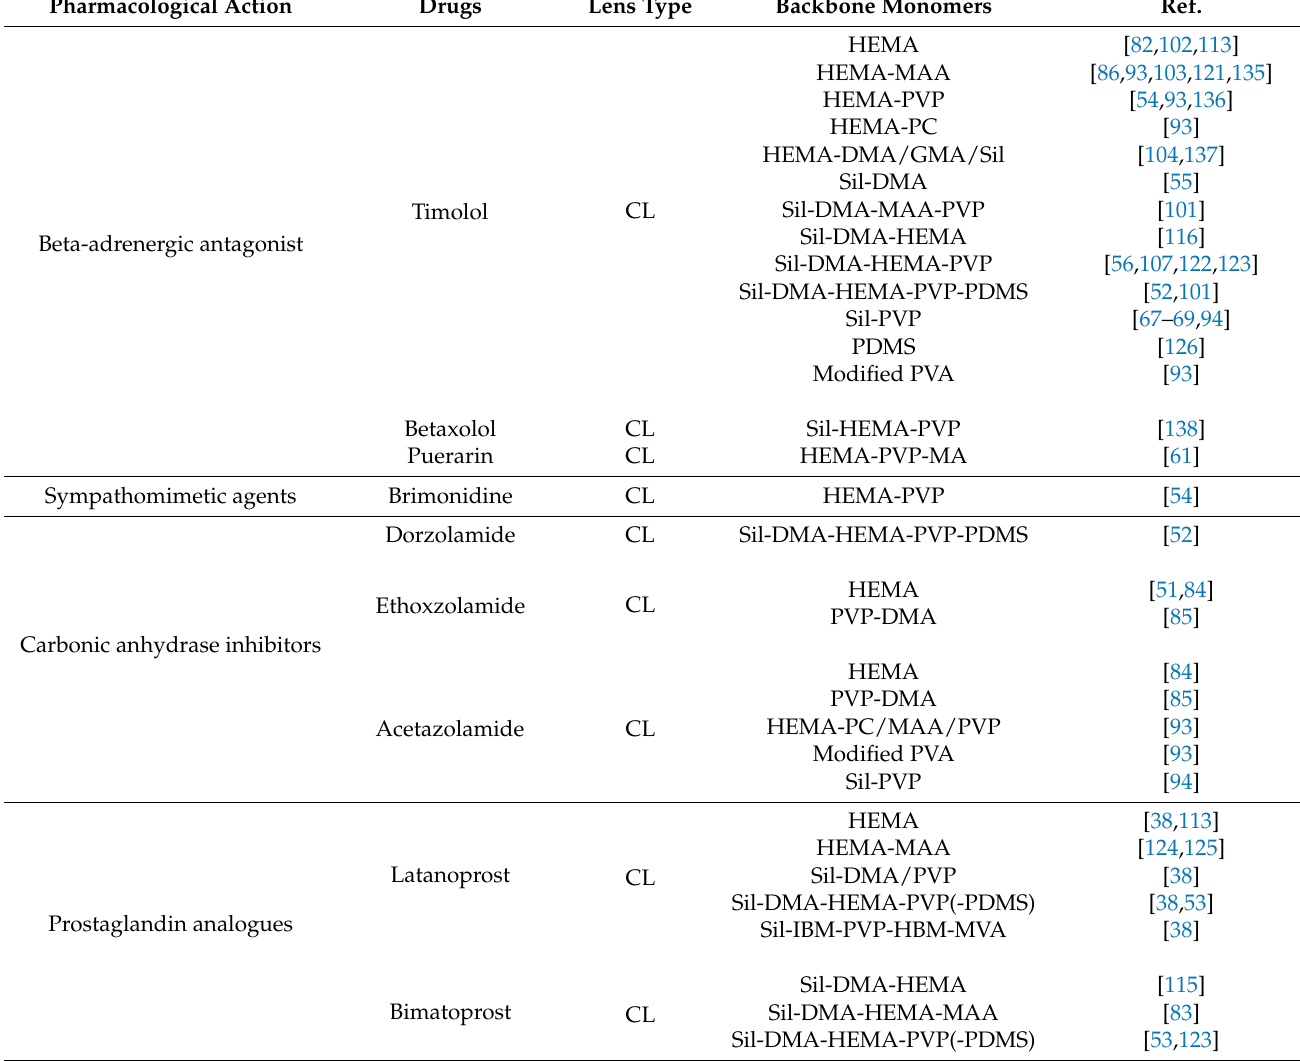
Table 1. Therapeutic ophthalmic lenses developed between 2010 and 2020 suitable for the treatment of glaucoma. Pharmacological Action Drugs Lens Type Backbone Monomers